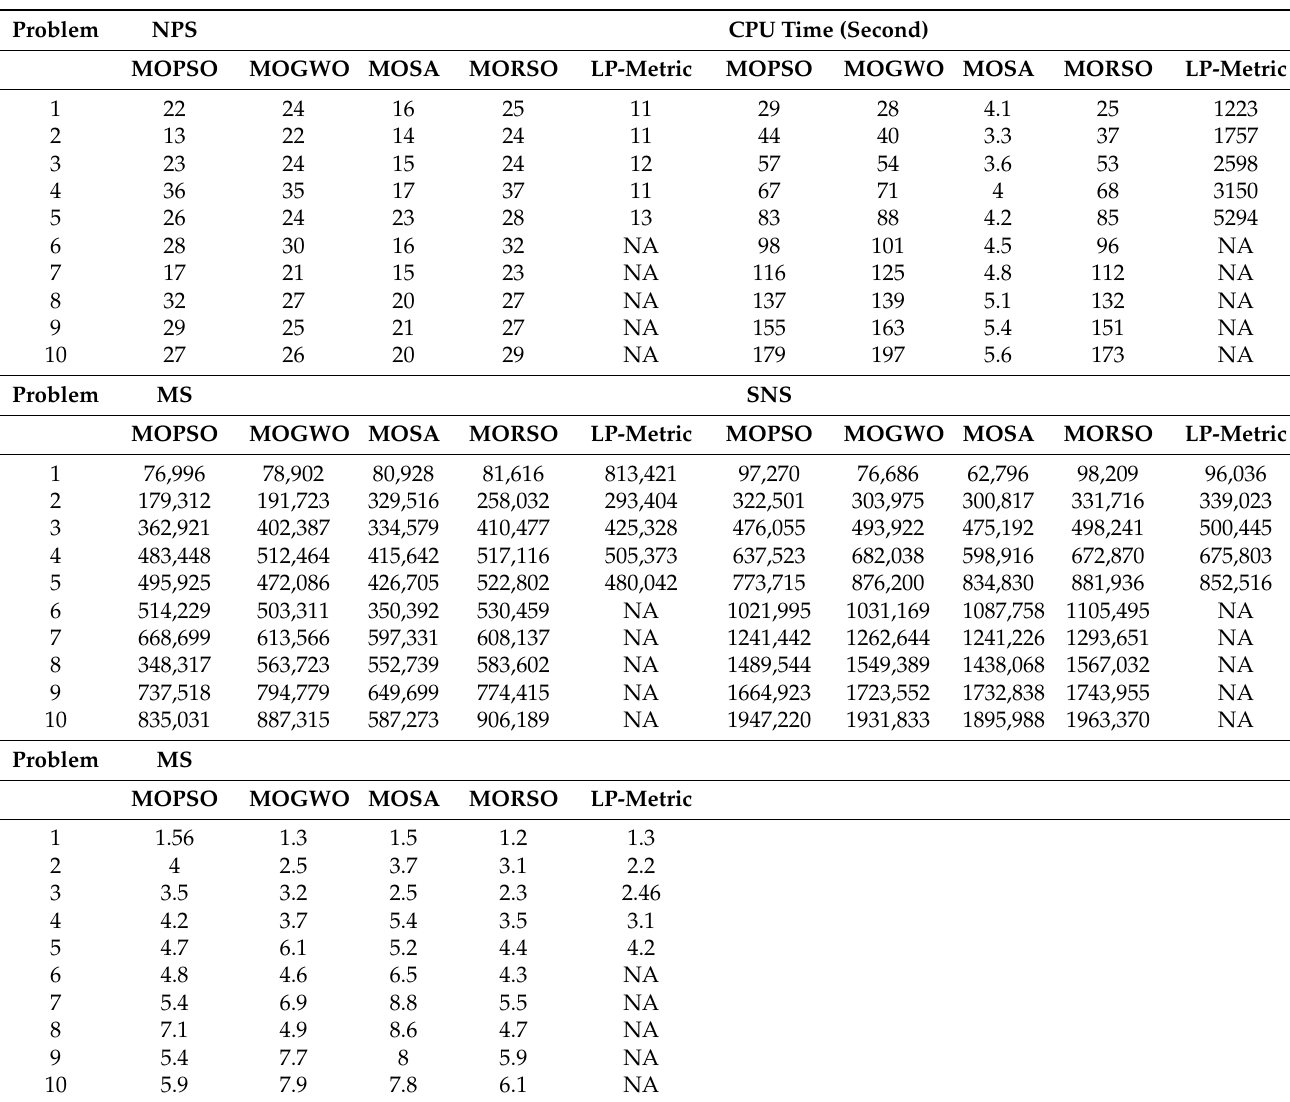
Table 6. Evaluation of mentioned algorithms in each metric